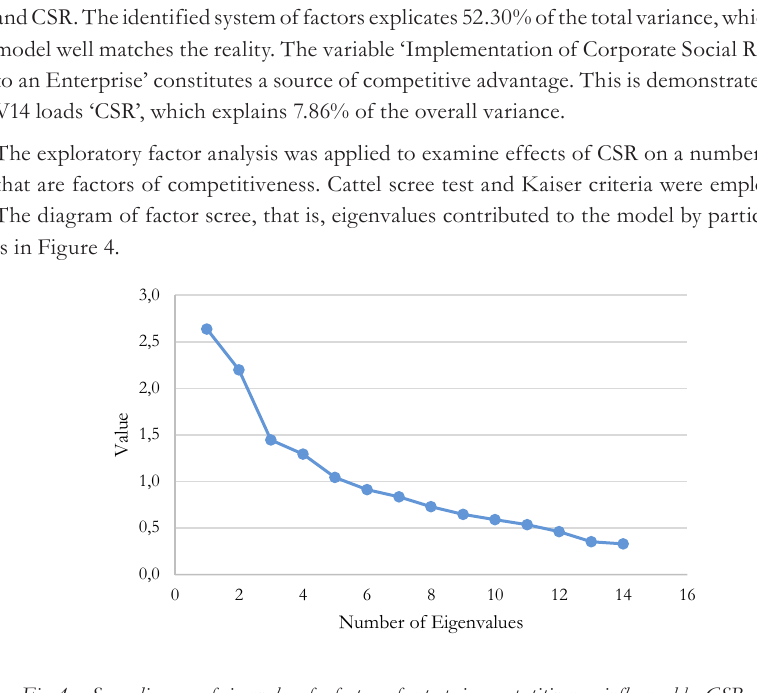
Fig. 4 – Scree diagram of eigenvalues for factors of enterprise competitiveness influenced by CSR. Source: own